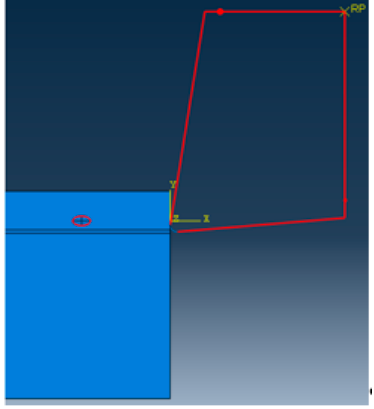
Figure 10. Contact setting of tool and particle.